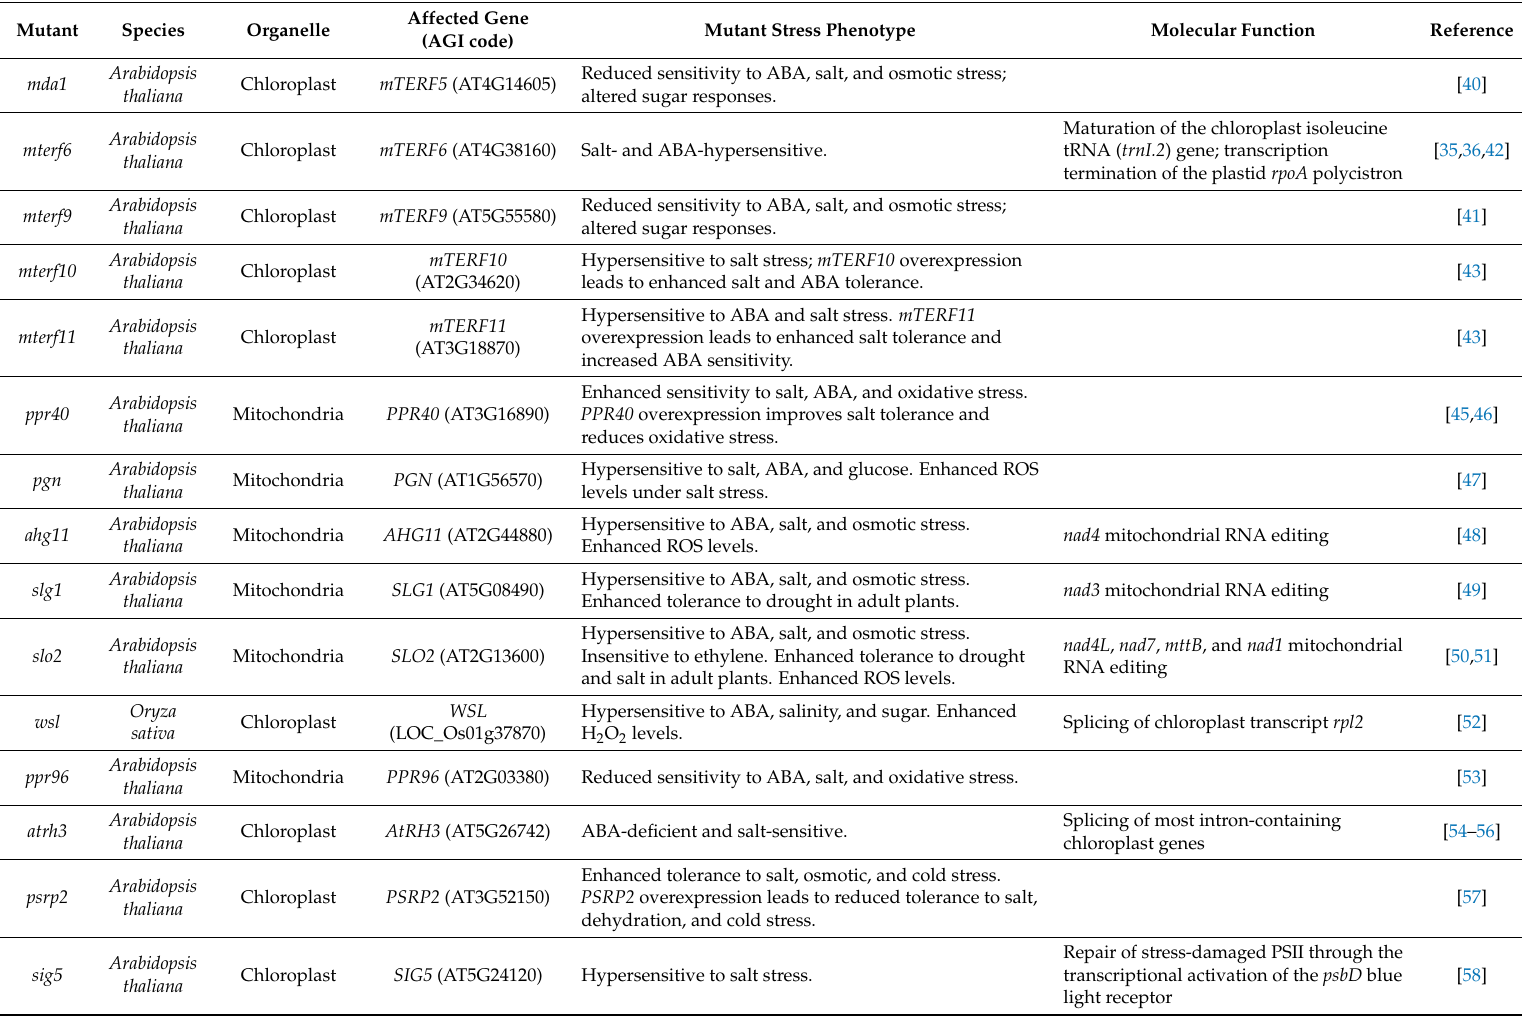
Table 1. Mutants affected in OGE displaying a salt stress